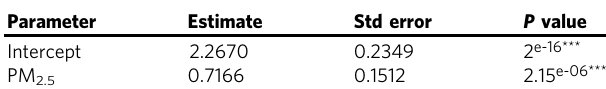
Table 2 Parameter and standard error (Std error) estimate for the Indigenous territory